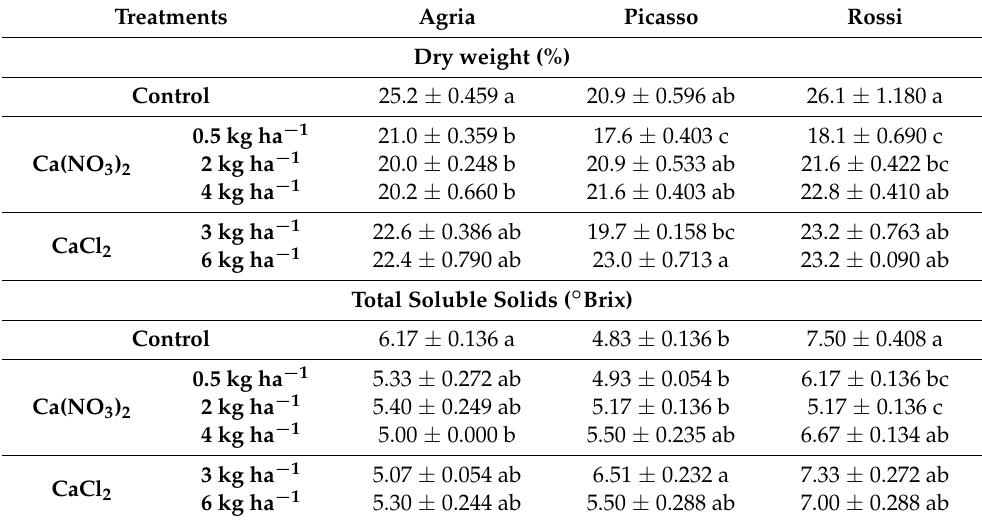
Table 4. Mean values ± S.E. ( n = 4) of dry weight and total soluble solids in tubers of Solanum tuberosum L., varieties Agria, Picasso and Rossi, at harvest.